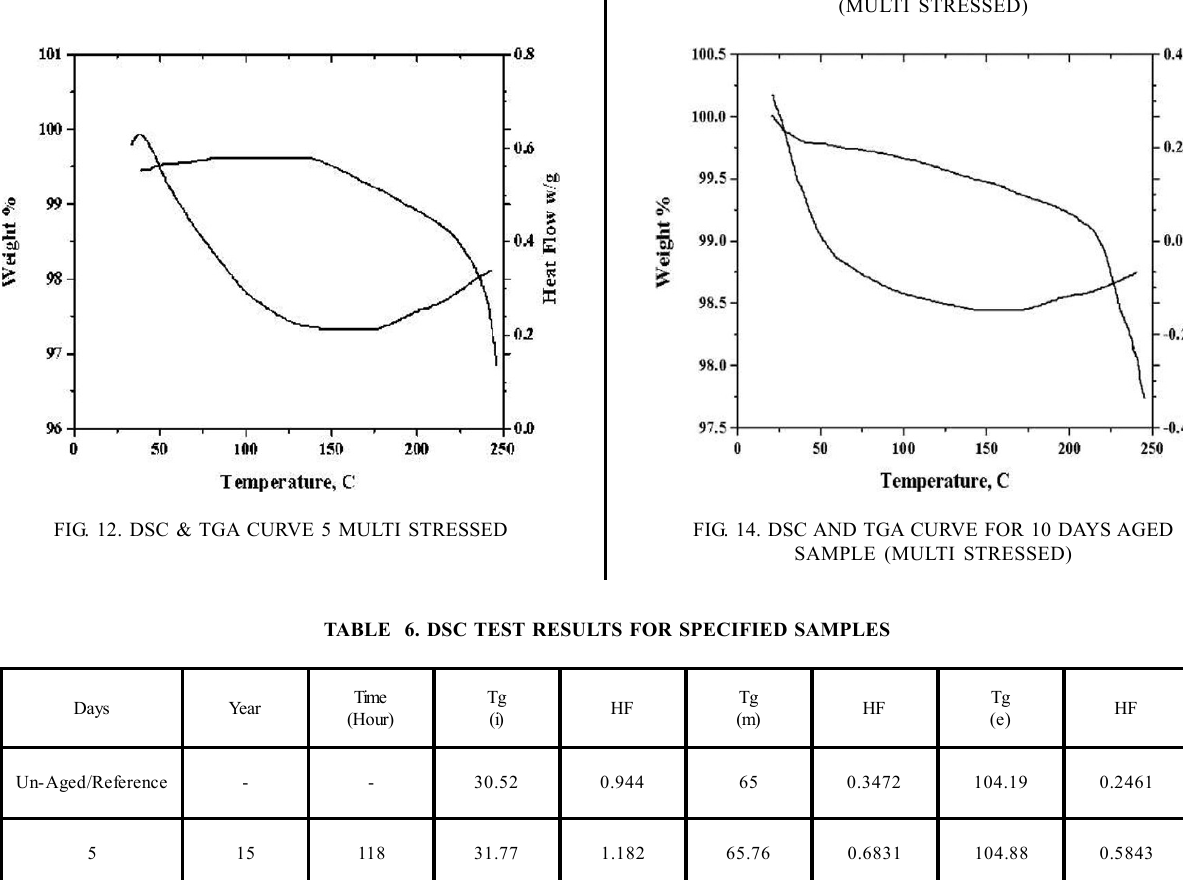
FIG. 11. DSC & TGA CURVE FOR 10 DAYS AGED